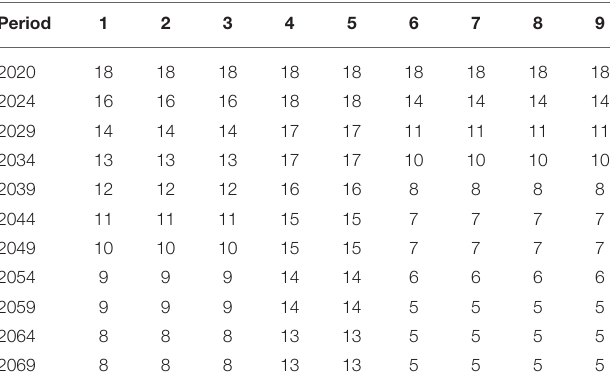
TABLE 3 | Projected saturated thickness (m) across nine field-level scenarios for a representative farm in Hale County, Texas. Period